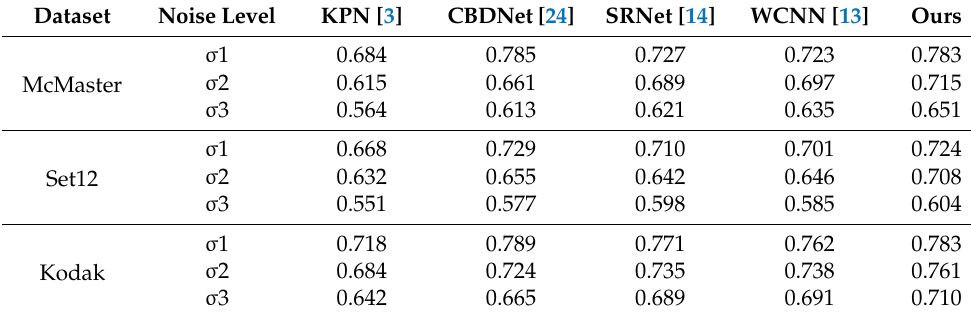
Table 3. The average PSNR(DB) results of different methods on three datasets.